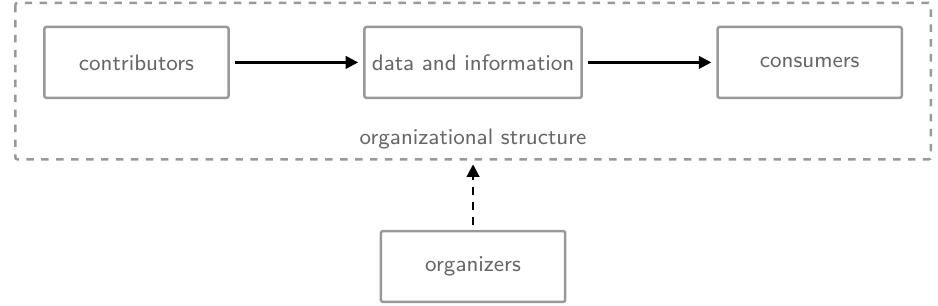
Figure 1. Conceptualization of Shared Data Sources (SDSs) by contributors, data and information, consumers, the organizational structure, and organizers. A contributor might also be a consumer or an organizer. Flow of data is depicted by solid arrows while the influence of the organizers on the entire process is depicted by a dashed